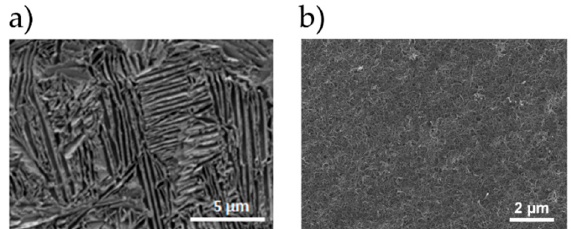
Figure 3. SEM images of Ti13Nb13Zr alloy before laser treatment. ( a ) MR; ( b ) MR with MWCNTs coatings.